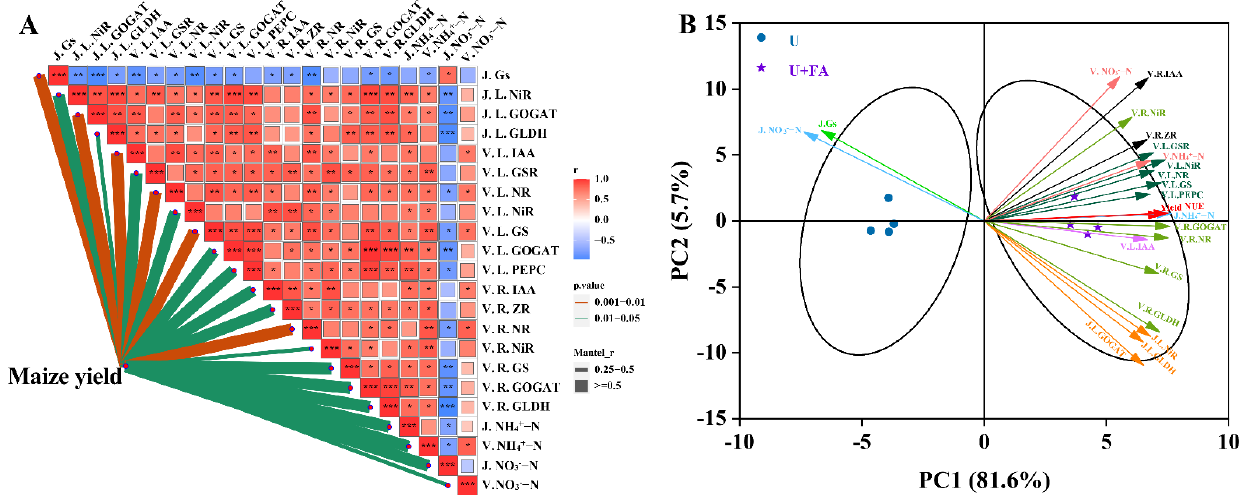
Figure 6. The correlations between maize yield, concentrations of nitrogen metabolism-related en- zymes, concentrations of photosynthetic key enzymes, concentrations of endogenous hormones, and soil available nutrients. ( A ) Mantel test. The thickness of a line indicates the strength of the correlation. The area of a rectangle represents the magnitude of the correlation. Red denotes a pos- itive correlation and blue represents a negative correlation. “*”, “**” and “***” indicate significant correlation at p < 0.05, p < 0.01 and p < 0.001, respective. ( B ) Principal component analysis showing the relationship among yield, NUE, soil nutrients, concentrations of nitrogen metabolism-related enzymes, concentrations of photosynthetic key enzymes of different treatment. (J: jointing stage; V: 12-leaf stage; L: leaves of maize; R: root of maize; Gs: stomatal conductance; IAA: auxin; ZR: zeatin nucleoside; NR: nitrate reductase; NiR: nitrite reductase; GS: glutamine synthetase; GSR: glutathi- one reductase; GOGAT: glutamate synthase; GLDH: glutamate dehydrogenase; Pn: net photosyn- thetic rate; Gs: stomatal conductance; Tr: transpiration rate; GA: gibberellin; ABA: abscisic acid; PEPC: phosphoenolpyruvate carboxylase).